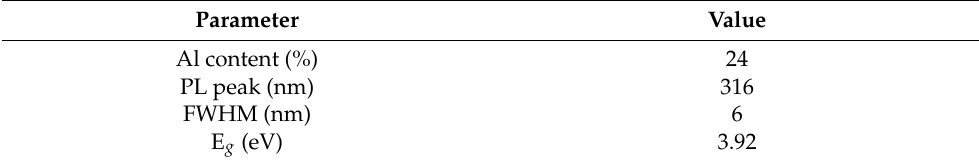
Figure 3. Images magnified 90 × using a photomicroscope of MS TECH’s MST-8000C probe station: top views of an asymmetric MSM AlGaN UV sensor ( a ) before and ( b ) after selective annealing (annealed region is marked with dotted box). Table 2. Important parameters for the MSM AlGaN UV sensor.